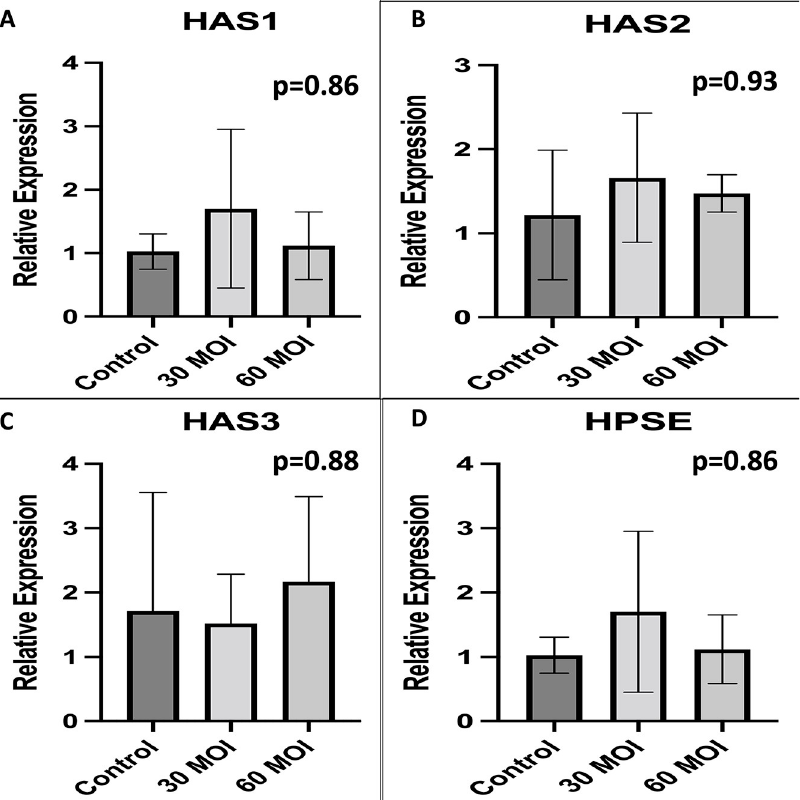
Fig 9. Pro-glycocalyx agents after H1N1. A comparison of pro-glycocalyx agent expression as measured by real-time PCR demonstrating that there is no difference in A) HAS1 and B) HAS2 or C) HAS3 when H1N1 infected human umbilical vein endothelial cells are compared to control. In addition, there is no difference in heparinase expression as measured by real-time PCR.